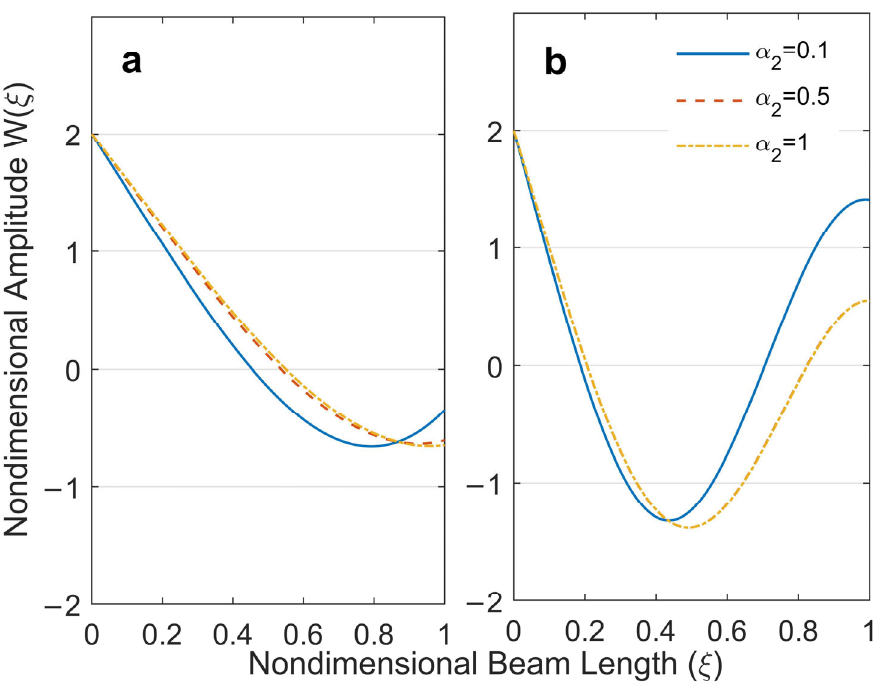
Figure 4. First and second mode shapes of the free–free beam with various 𝛼 (cid:2870) values: ( a ) first mode shape, ( b ) second mode shape.